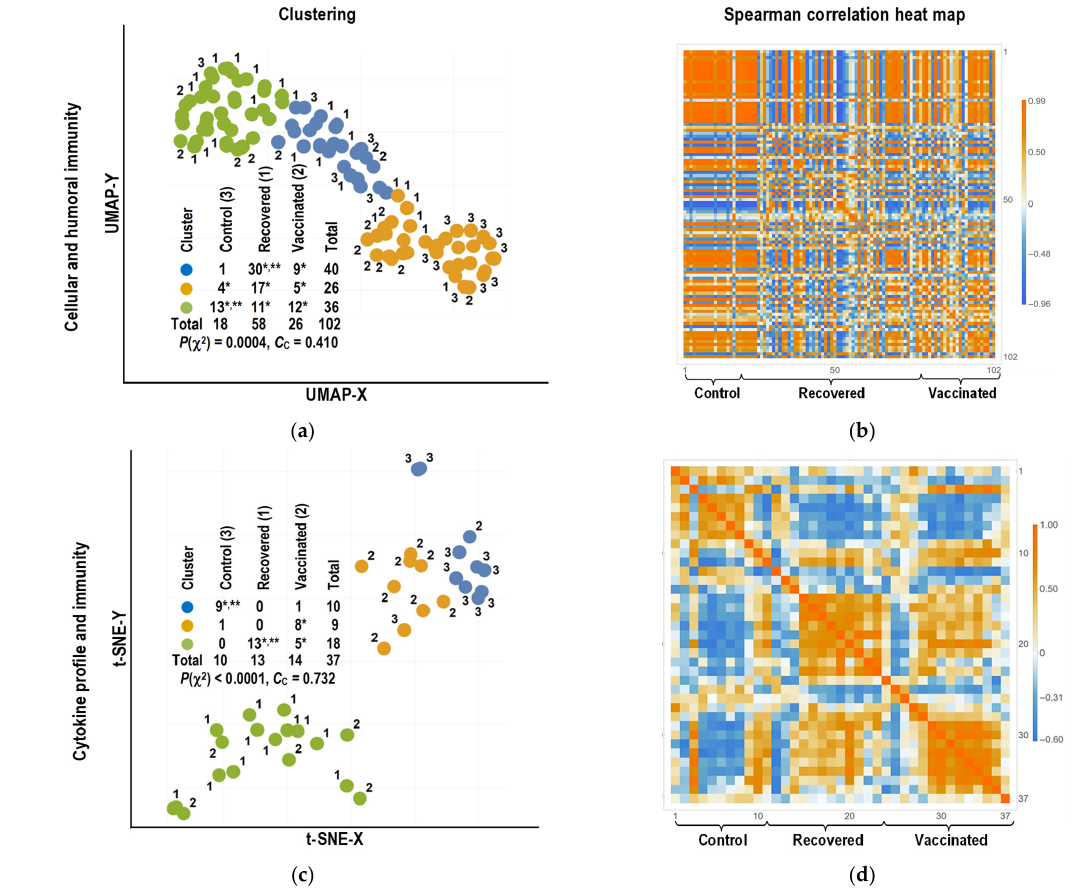
Figure 7. Bioinformatics analysis with individual clustering by cellular and humoral immunity parameters and cytokine profile of individuals. ( a , c ) Clustering results; ( b , d ) Spearman rank correlation coefficient heat diagrams. In images with clustering results, circles of the same color indi ‐ cate individuals of the same cluster. The numbers near the circles represent the clinical group: 1—recovered individuals, 2—vaccinated individuals, and 3—control individuals. The presented contingency tables contain the number of representatives of each clinical group in the clusters. * The proportion of individuals in the cluster significantly exceeds 0.05 of the number of individuals with the corresponding clinical status ( p < 0.01). ** The proportion of individuals in the cluster sig ‐ nificantly exceeds the proportion of individuals with the corresponding clinical status in all other clusters ( p < 0.01).